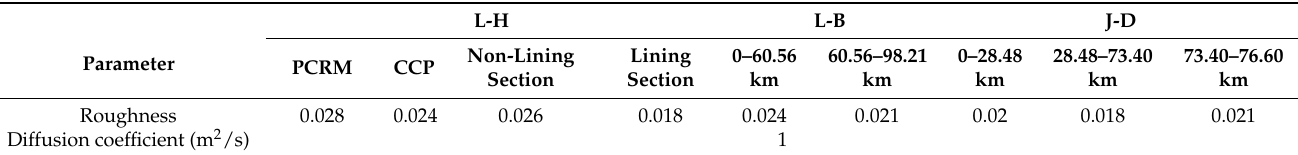
Table 1. Some design parameters of the Shandong